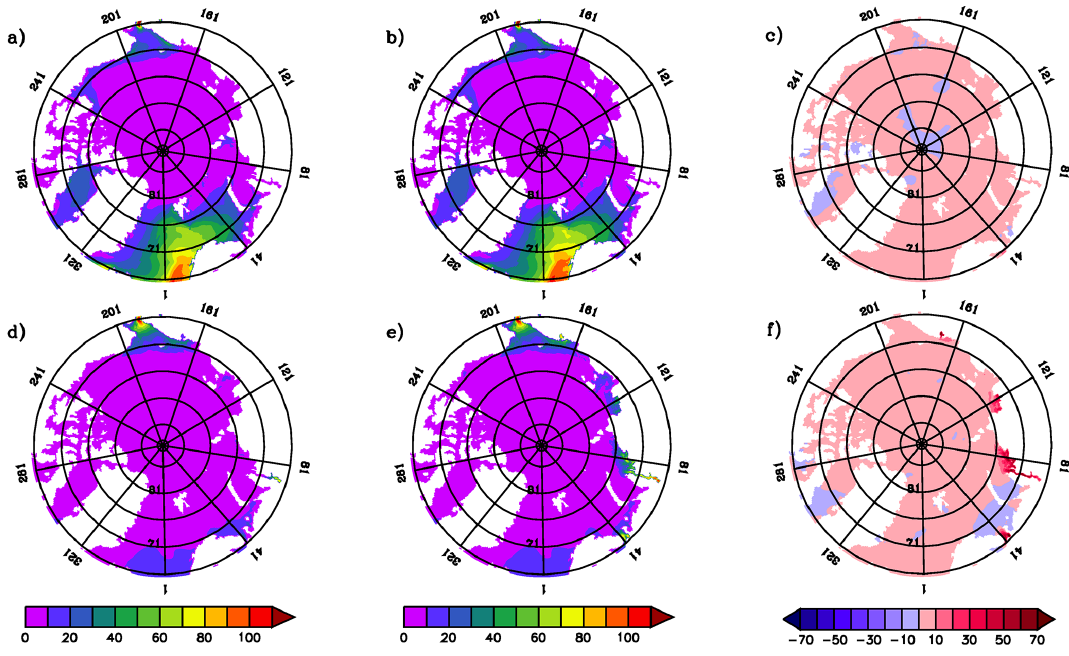
Figure 3. Mean annual new primary production (gCm − 2 ; upper panels) and NH 4 -supported primary production (gCm − 2 ; lower panels) over 1998–2011 simulated in the CTRL run (left panels a and d ) and the RIV run (middle panels b and e ). Right panels ( c and f ) provide the absolute difference (gCm − 2 ; RIV run – CTRL